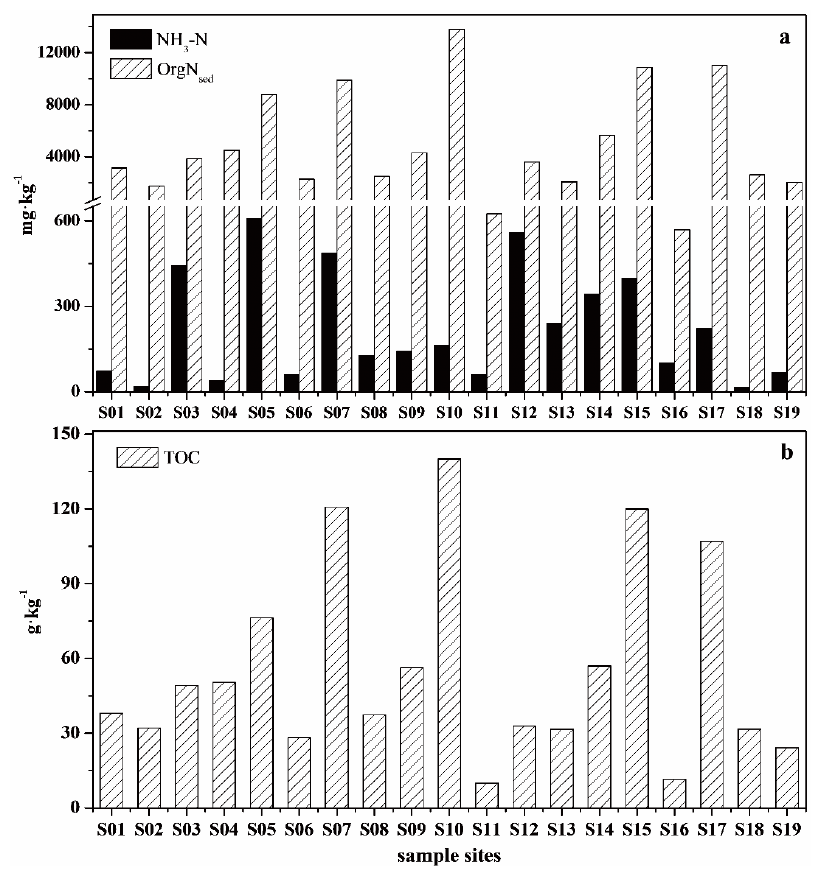
Figure 3. Concentrations of ( a ) NH 3 -N; OrgN water and ( b ) TOC in surface sediment